Question: Sum up the contents of this chart in one sentence.
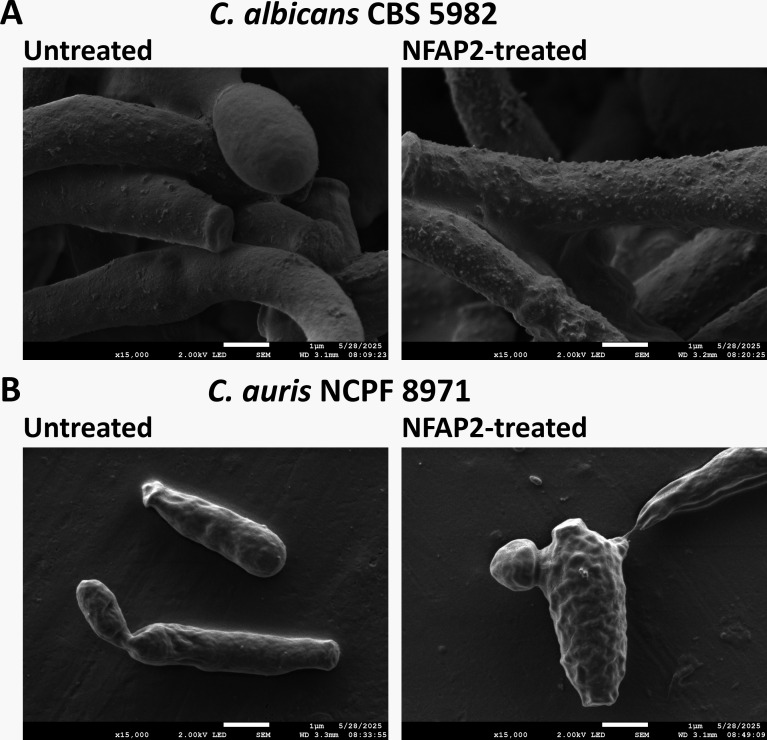
Answer: NFAP2 induces severe species-specific structural damage in early-stage filamentous C. albicans and pseudohyphal C. auris cells as determined by SEM. Early-stage filamentous C. albicans CBS 5982 and pseudohyphal C. auris NCPF 8971 cells were exposed to NFAP2 in LCM at 37°C under continuous shaking for 2 h. C. albicans cells were treated with 6.25 µg mL⁻ 1 NFAP2, whereas C. auris cells were treated with 50 µg mL⁻ 1 NFAP2 (apparent MIC values see Table S1 ). Untreated morphotype-matched cells served as controls. Untreated C. albicans early-stage hyphae display smooth, continuous surfaces characteristic of healthy polarized growth. In contrast, NFAP2-treated hyphae exhibit markedly altered surface architecture, including extensive wrinkling, uneven contours, and prominent globular protrusions, consistent with substantial cell envelope structural alterations that may reflect cell wall- and/or membrane-associated effects, although precise mechanisms cannot be resolved from SEM alone ( A ). Untreated C. auris pseudohyphae maintain elongated morphology with smooth surfaces, uniform diameter, and intact cell wall architecture. NFAP2 treatment is associated with profound structural deterioration, including roughened and irregular surfaces, collapsed and twisted filaments, swollen or distorted regions, and frequent localized ruptures with membrane extrusions. Hyphal tips appear blunted or deformed, reflecting disrupted polarized extension ( B ).